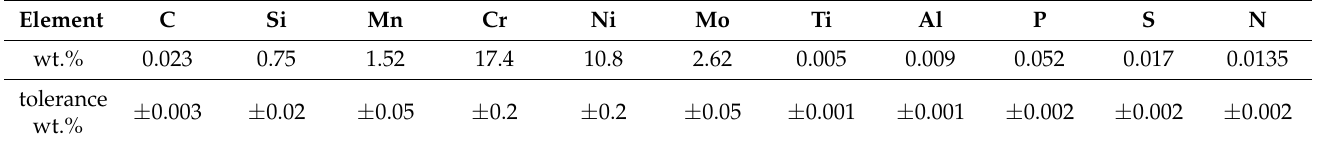
Table 1. Chemical composition of SS2343 austenitic steel in